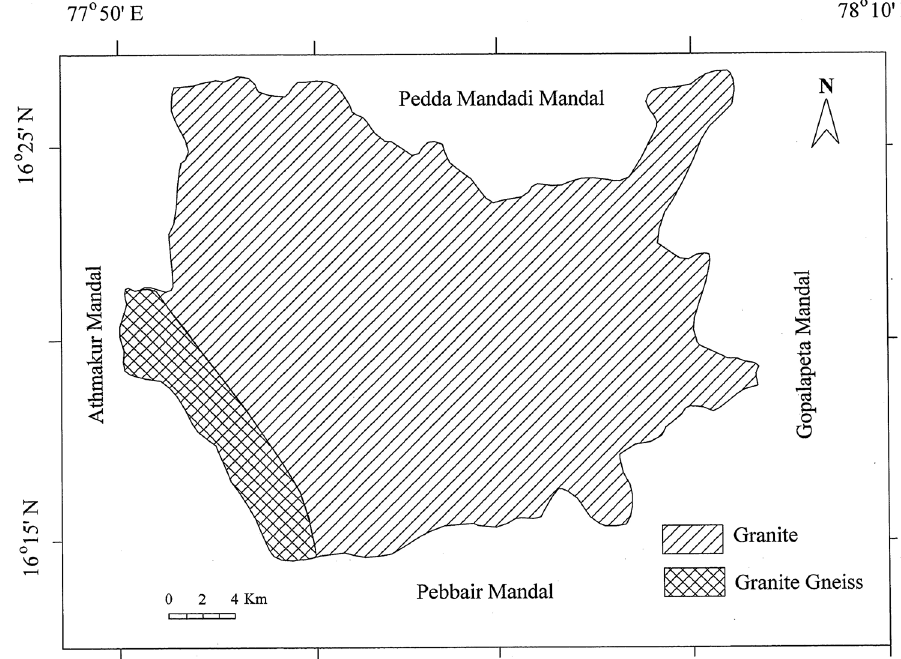
Fig. 2 Geological formations (after CGWB